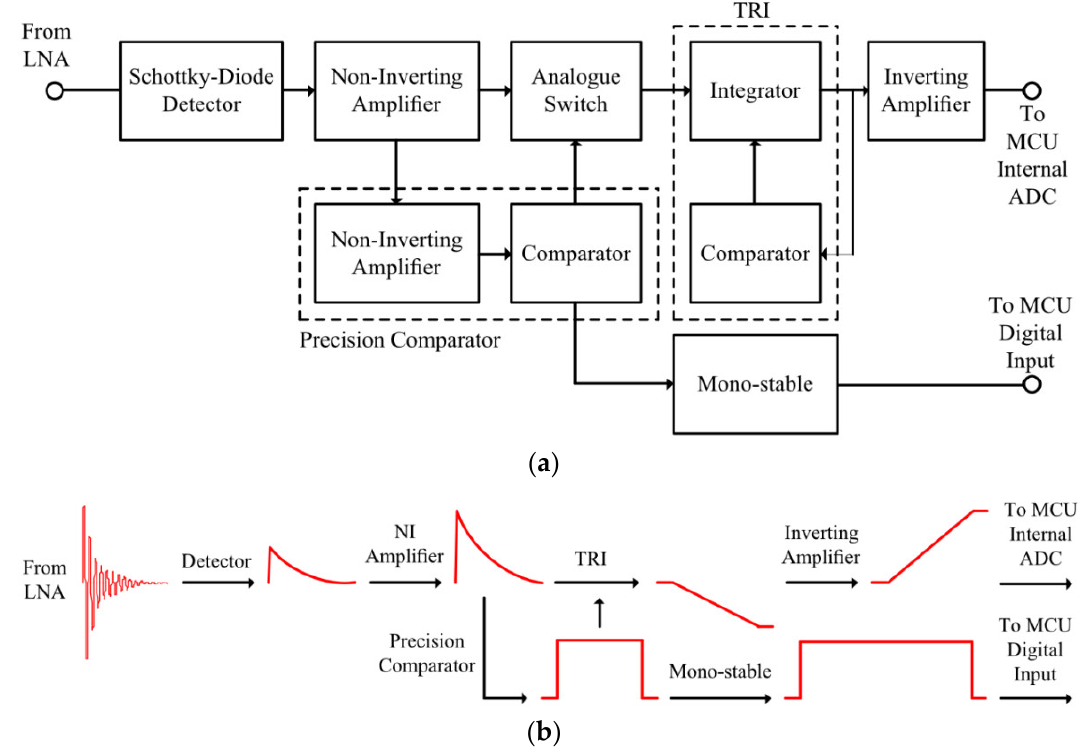
Figure 14. Transistor reset integrator (TRI): ( a ) block diagram and ( b ) signals [78].